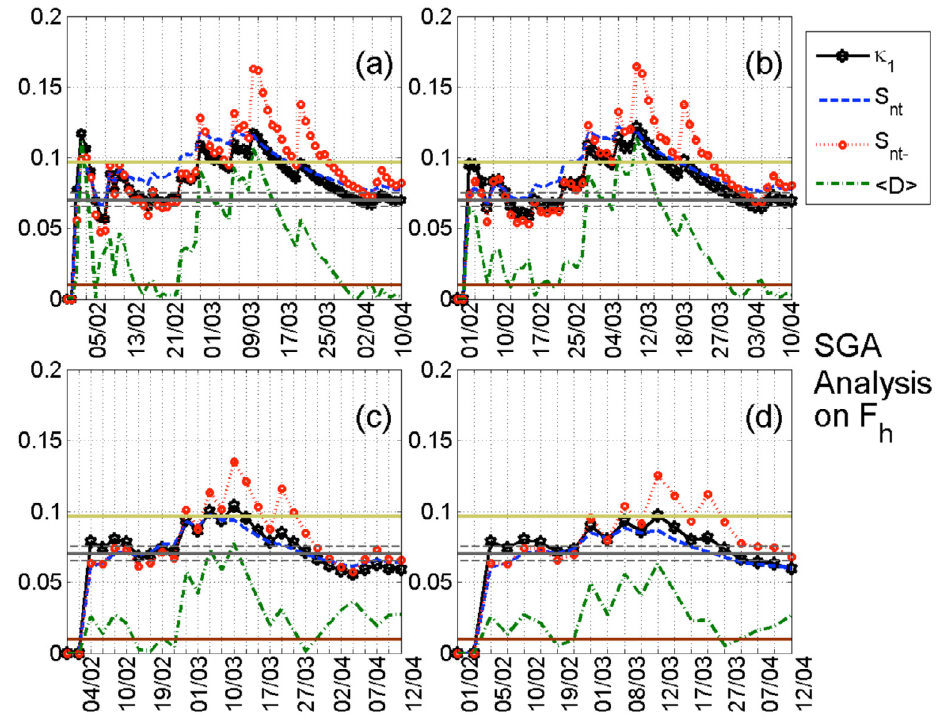
at SGA for the time period of February 1 through April 12, h , S , S , and 〈 D 〉 ) for the different thresholds F (in arbitrary unit) nt nt − h,thres 1